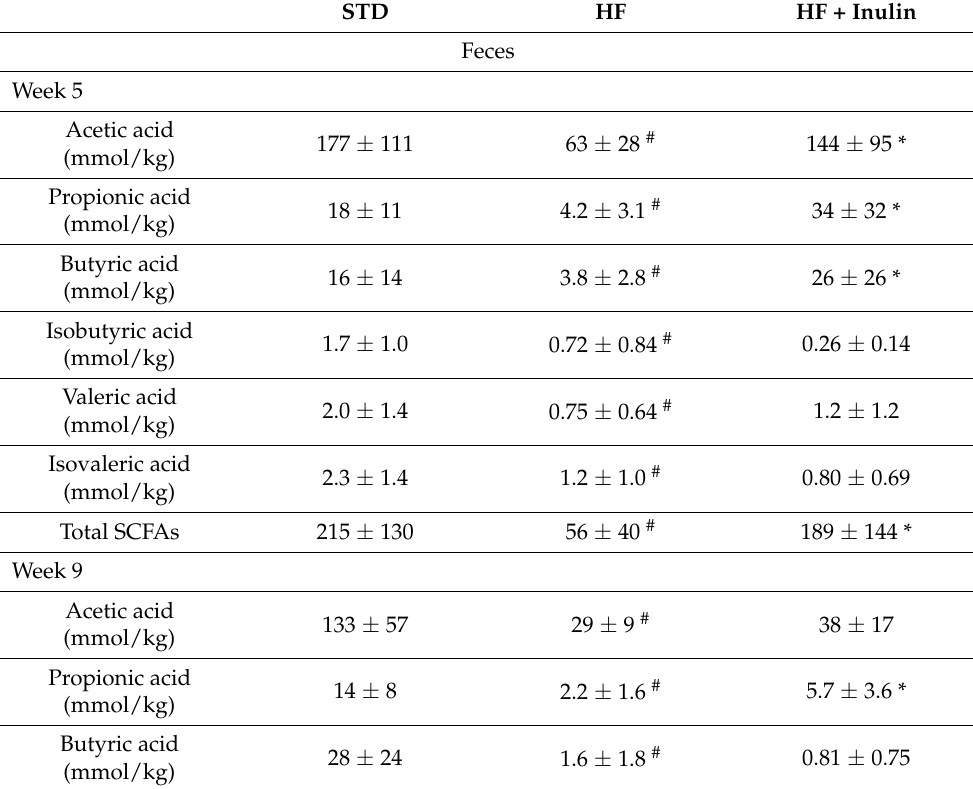
Table 1. Short-chain fatty acids in feces and cecal content (dry